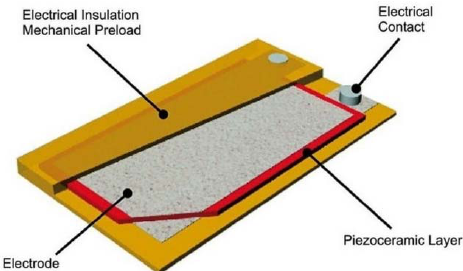
Figure 8. Piezo layer, P ‐ 876.A11 (from PI Ceramic website).